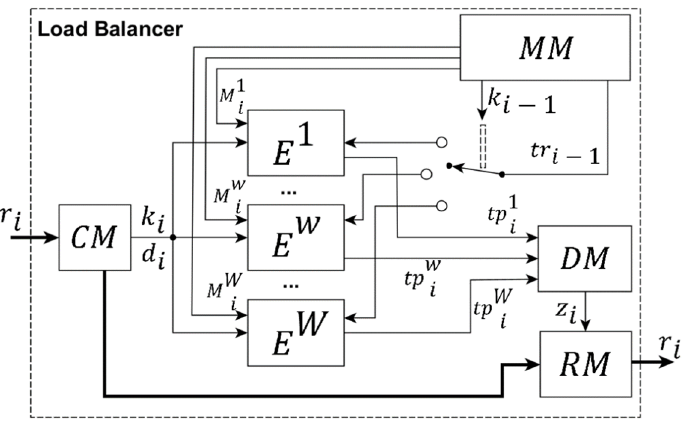
Figure 2. The load balancer diagram.